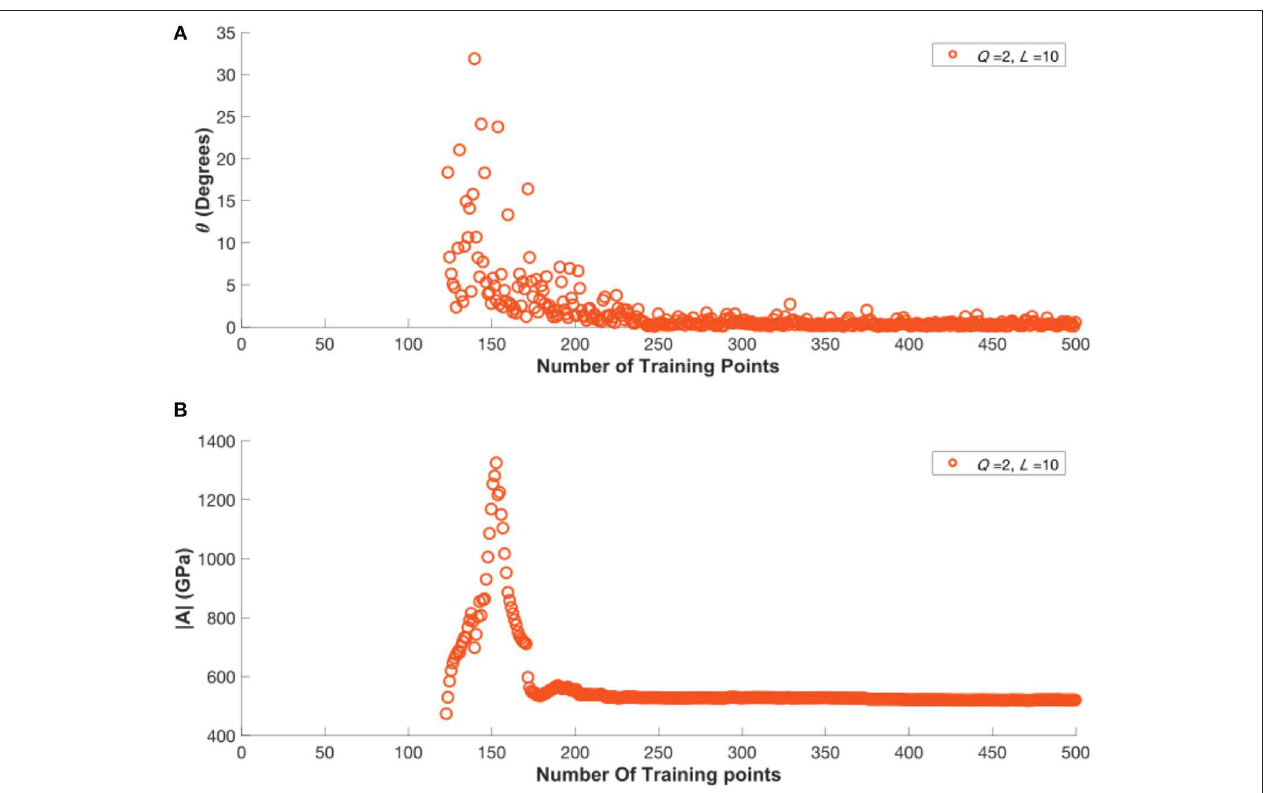
FIGURE 2 | (A) Variation in the angular change in the vector of model coefficients between model update steps. (B) Variation in the magnitude of the vector of model coefficients during the model building process.